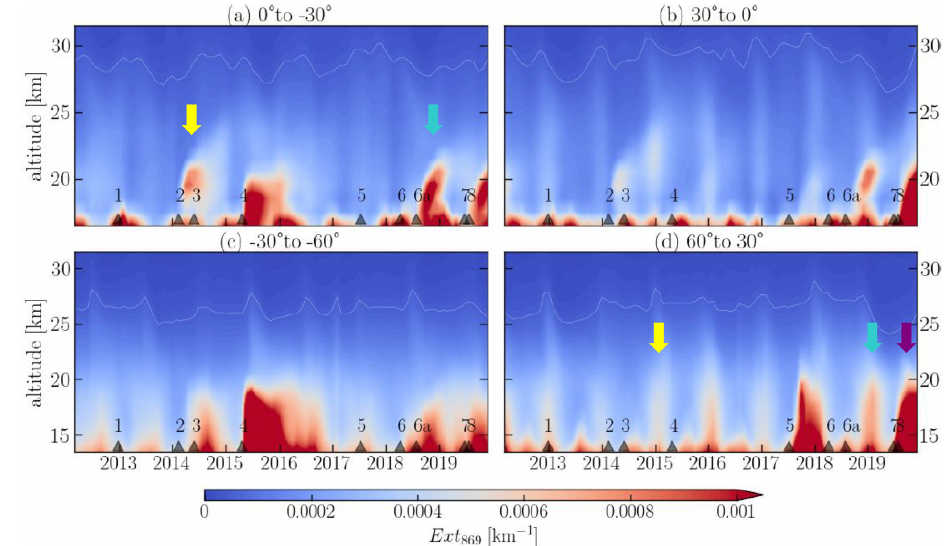
Figure 13. Monthly mean aerosol extinction coefficient (Ext 869 ) distribution from the OMPS-LP satellite instrument. The black triangles at the bottom of each panel represent volcanic eruptions and biomass burning events. Coloured arrows indicate the events which are important to this study. Adapted from Malinina et al.